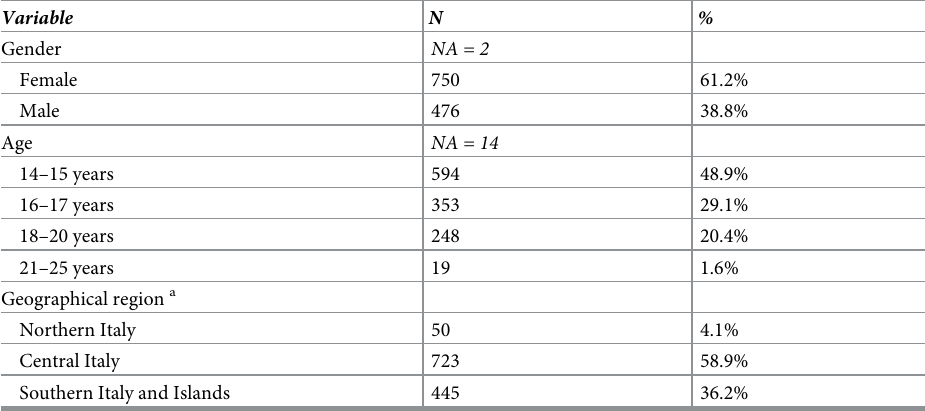
Descriptive statistics (frequencies) about the socio-demographic characteristics of the sample (N = 1.228). a Regions in Northern Italy: Trentino Alto-Adige, Lombardia, Valle d’Aosta, Piemonte; Regions in Central Italy: Tuscany, Lazio; Regions in Southern Italy: Campania,